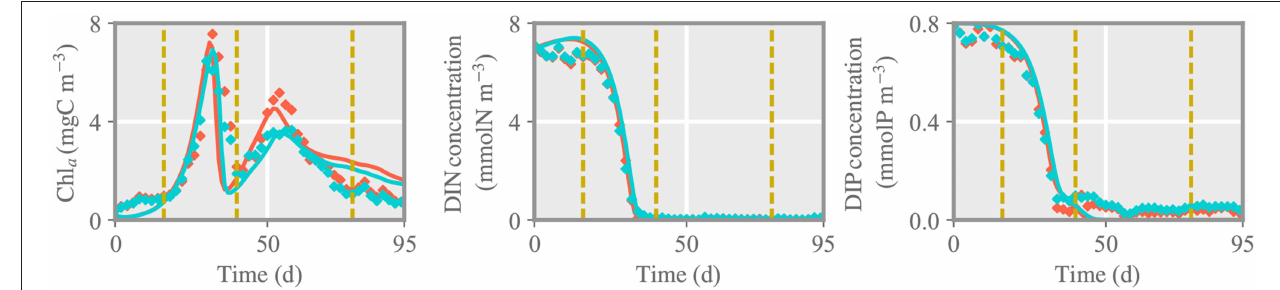
FIGURE 2 | Comparison between chlorophyll a (chl a ), dissolved inorganic nitrogen and phosphorous concentration (DIN, DIP) of the reference run and measured data for the control (LpCO 2 , blue) and treated (HpCO 2 , red) mesocosms. Solid lines and diamonds represent model results and measured data, respectively. Dashed lines separate different phases of the experiment: initial, first and second spring bloom, and post-bloom